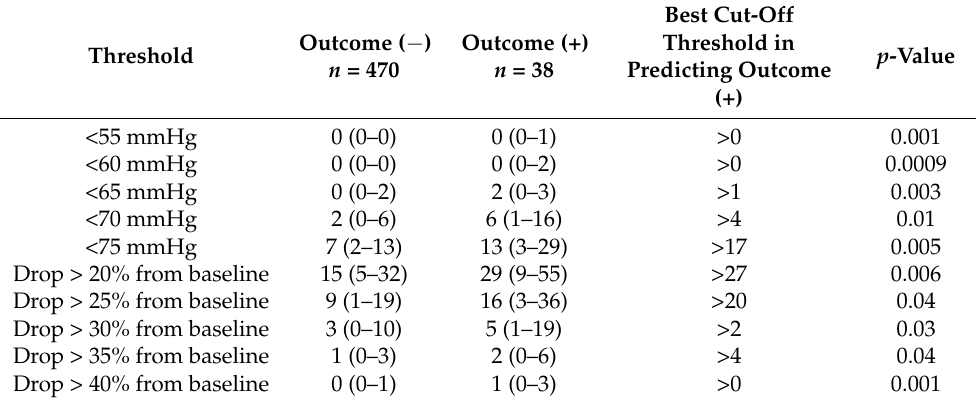
Table 4. Number of episodes spent under each of absolute and relative IOH thresholds.